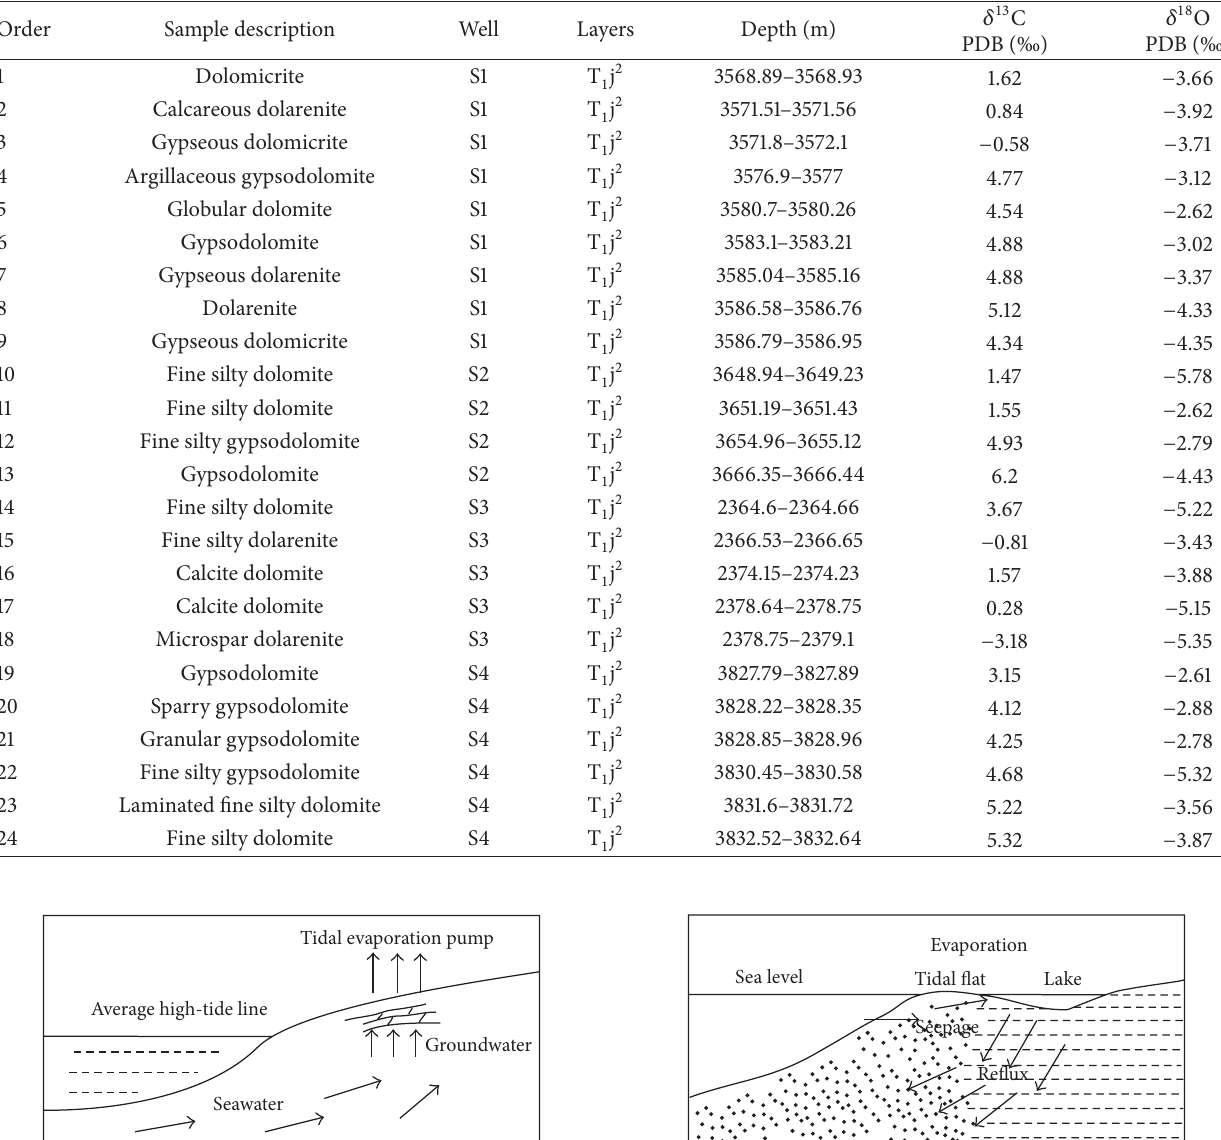
Table 1: Carbon and oxygen isotopic sampling data for carbonate rocks.